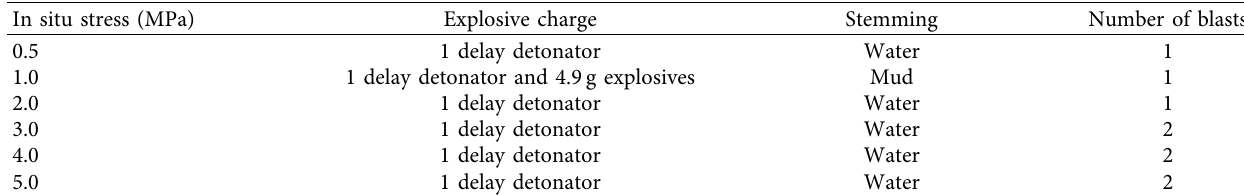
Figure 6: The crack distribution patterns of the parent body of Model 1 using the ZDF-3 electric spark. (a) No cracks visible on the top surface of the parent body. (b) A Livingston blast crater with a diameter of approximately 52 cm and a depth of 10cm at the bottom of the parent body. Table 3: Parameters of filling delay detonator and explosive in Model